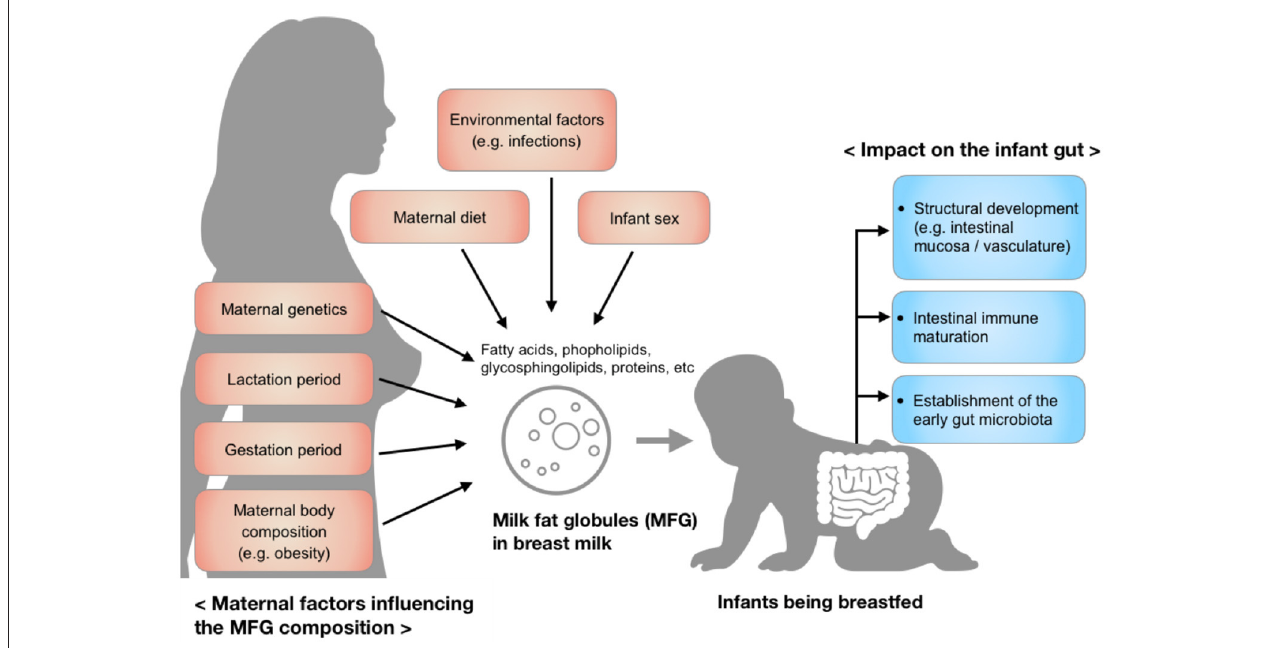
FIGURE 1 | Factors influencing the composition of milk fat globules in breast milk and the impact of those components on the infant gut during early